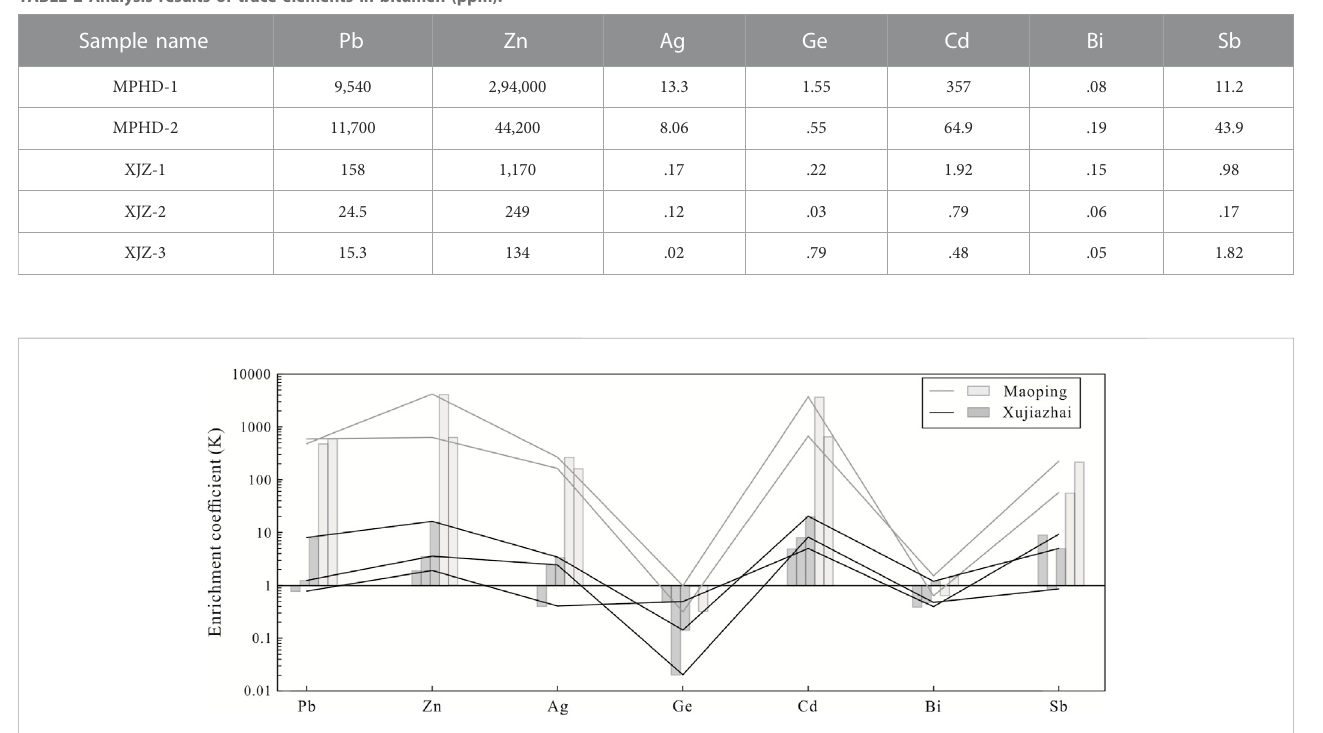
FIGURE 9 Enrichment diagram of major metals (Pb, Zn) and recoverable metal elements in